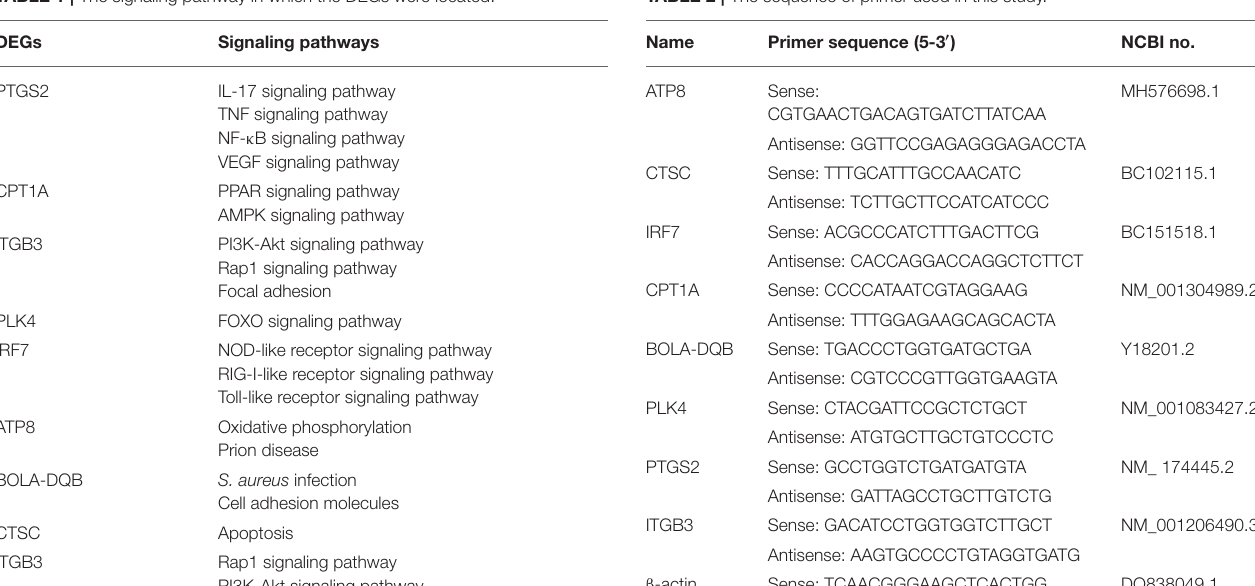
TABLE 1 | The signaling pathway in which the DEGs were